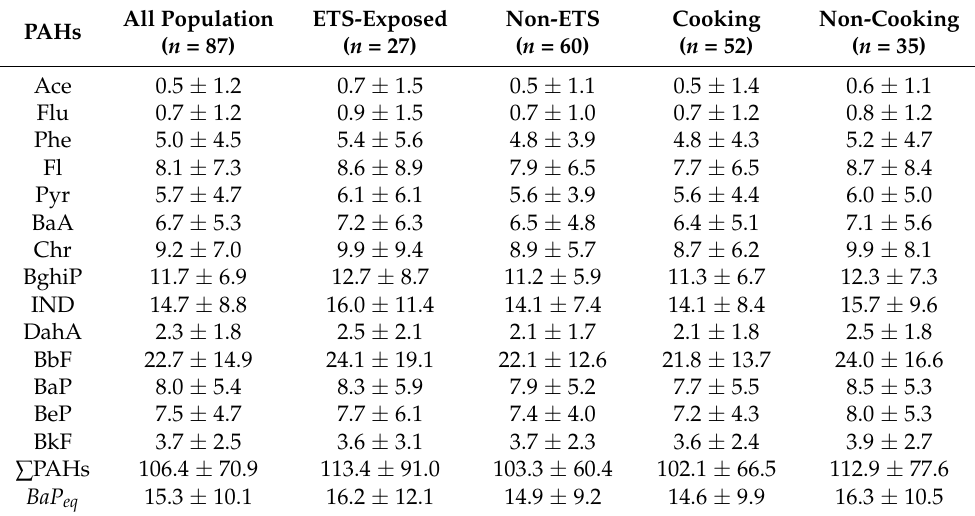
Table 2. Polycyclic aromatic hydrocarbons concentrations based on personal PM 2.5 samples (ng/m 3 ). All Population ETS-Exposed Non-ETS Cooking Non-Cooking PAHs ( n = 87) ( n = 27) ( n = 60) ( n = 52) ( n = 35) Ace 0.5 ± 1.2 0.7 ±